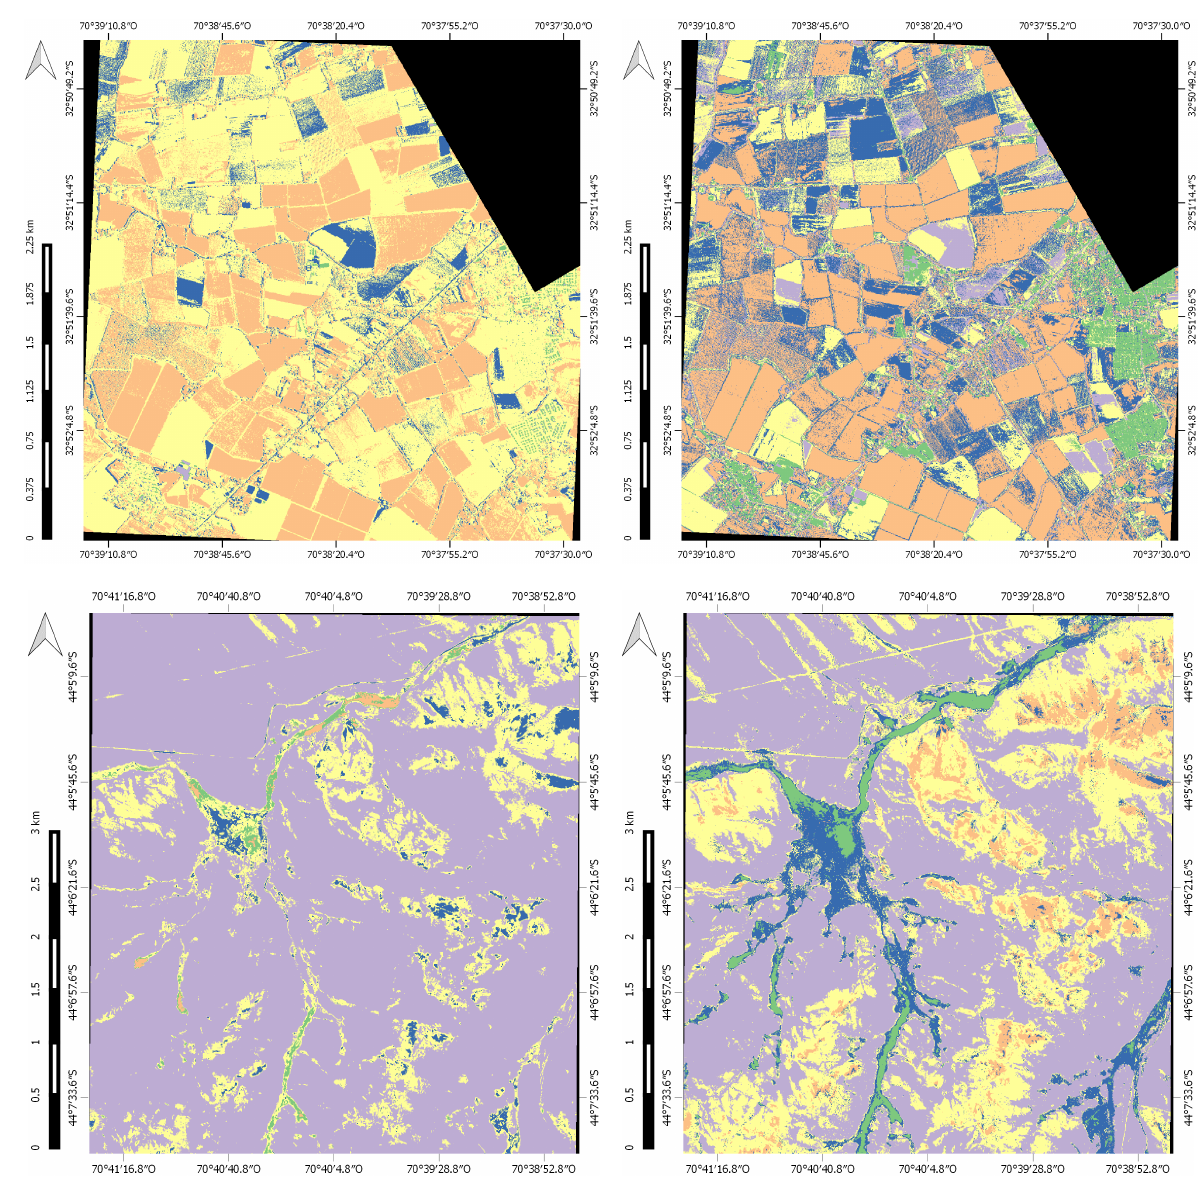
Figure 6. Region-merging methods’ comparison; five final spectral clusters. Upper row: image CHILE2. Color distance (left image) and co-occurrence in superpixels (right image). Lower row: image ARGENTINA. Color distance (left image) and co-occurrence in superpixels (right image). Colors have no special